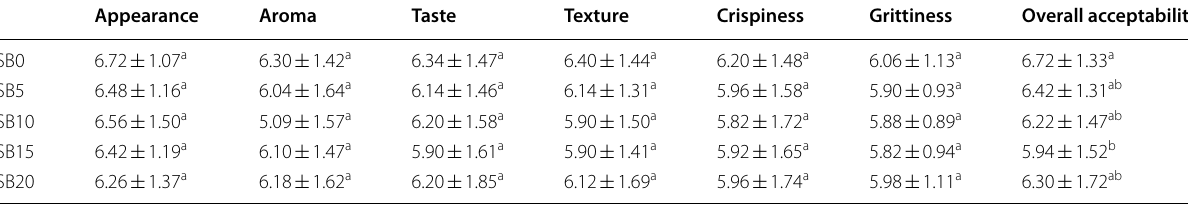
Values are expressed as mean SB0: 100% Plantain biscuit, SB5: 95% Plantain Plantain